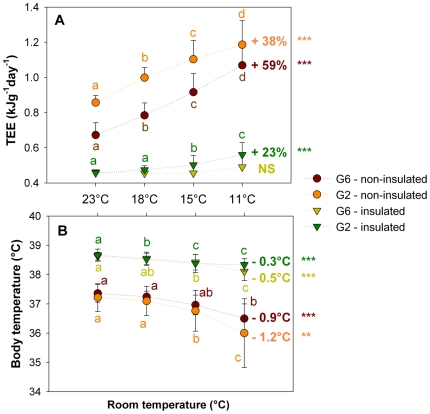
Relationship between total energy expenditure (TEE) and body temperature of insulated and non-insulated pups, huddling in groups of 6 (G6) or placed in groups of 2 (G2), during the cold challenge.Different letters indicate significant differences. ***: significant differences with p<0.0001 between 23°C and 11°C; **: significant differences with p<0.002 between 23°C and 11°C. NS: not significant.